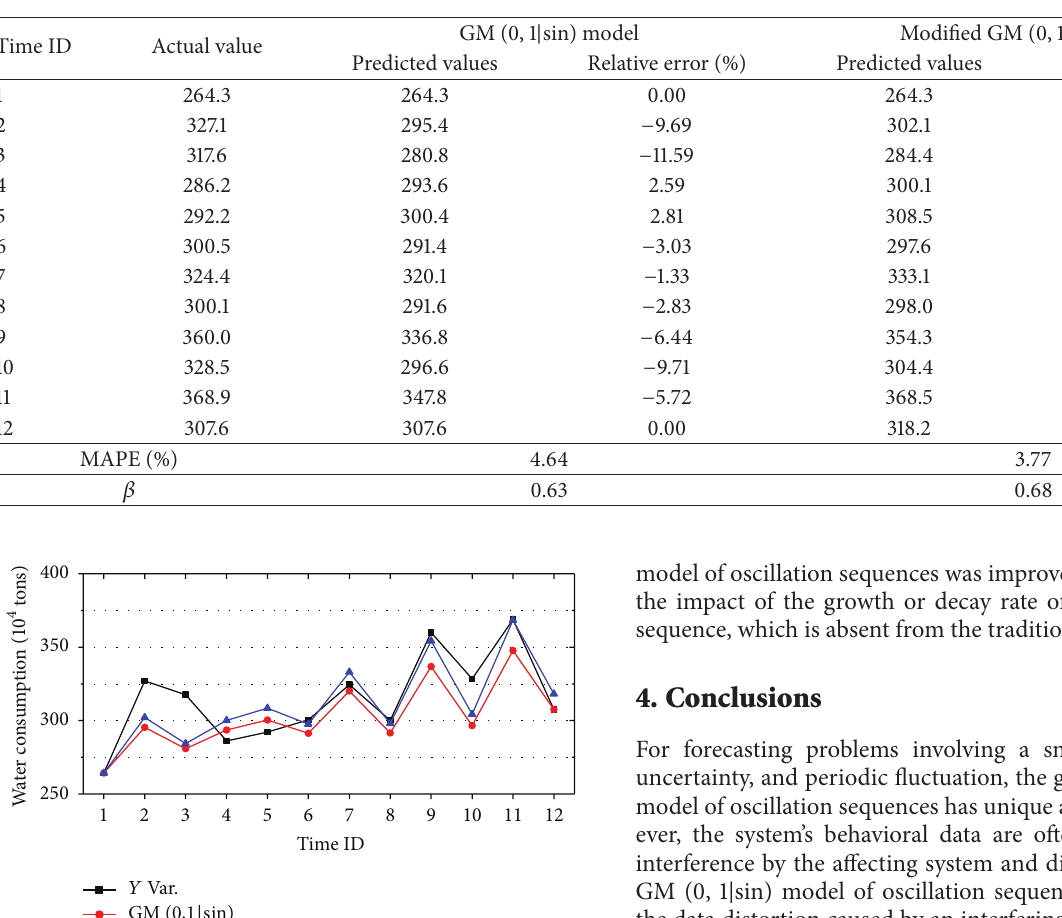
Table 2: The predicted values by different models and their relative error.